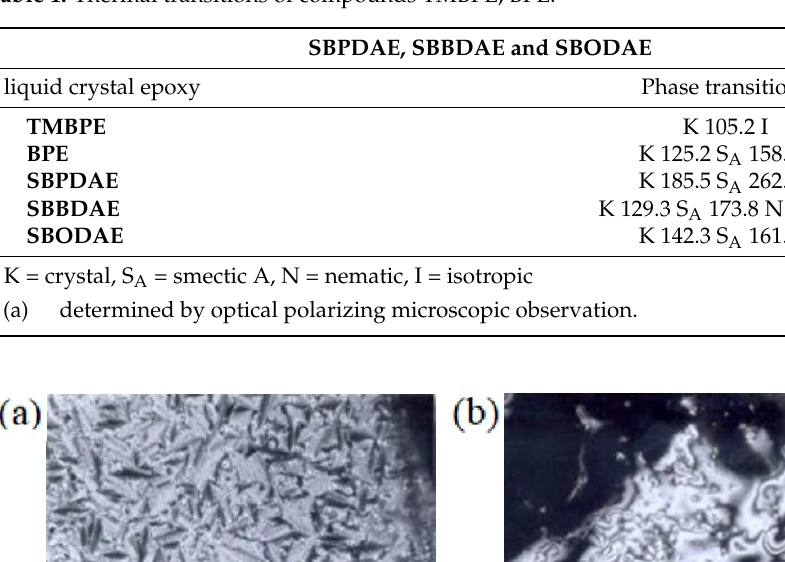
Table 1. Thermal transitions of compounds TMBPE, BPE.